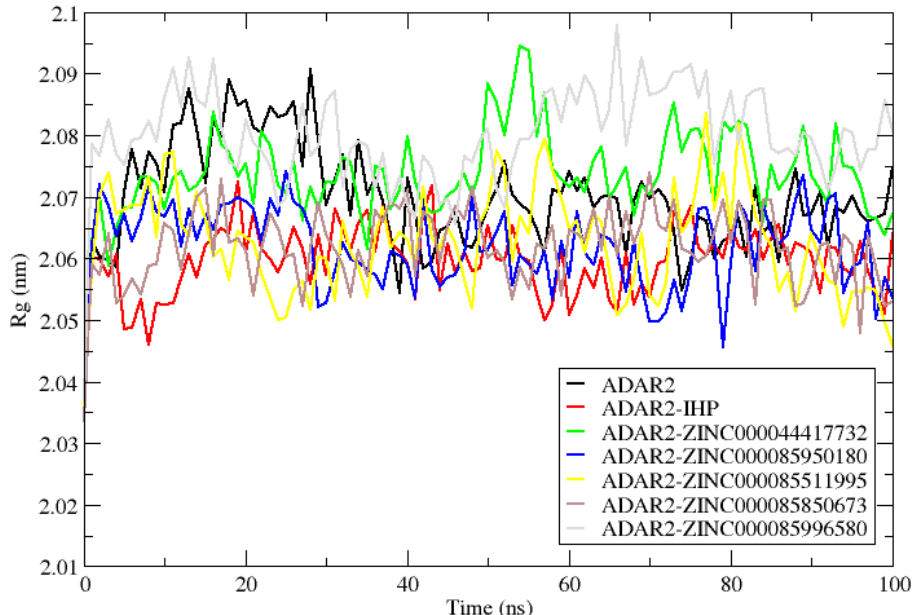
Figure 6. Radius of gyration plot of the unbound ADAR2 and ADAR2-ligand complexes. The unbound protein, ADAR2-IHP, ZINC000044417732, ZINC000085950180, ZINC000085511995, ZINC000085850673, and ZINC000085996580 complexes are colored black, red, green, blue, yellow, brown, and grey, respectively. The Rg values of ADAR2-ZINC000085996580 complex fell until ~50 ns where a sharp rise was observed (Figure 6). The Rg rose to ~2.09 averagely until 90 ns and then fell again (Figure 6). The ADAR2-ZINC000100513617, ZINC000013462928, and ZINC000085511995 complexes also demonstrated fluctuations similar to that of the ADAR2-ZINC000085996580 complex. The ADAR2-ZINC000013462928 complex maintained quite a stable Rg with an average of 2.075 nm until ~80 ns and then declined to an average of 2.06 nm until the end of the 100 ns simulation time (Figure S3B). The Rg of the ADAR2-ZINC000100513617 complex, however, increased after 90 ns (Figure S3B). Collectively, all the complexes and the unbound protein had relatively low Rg values, indicating that they were stable and compact in their